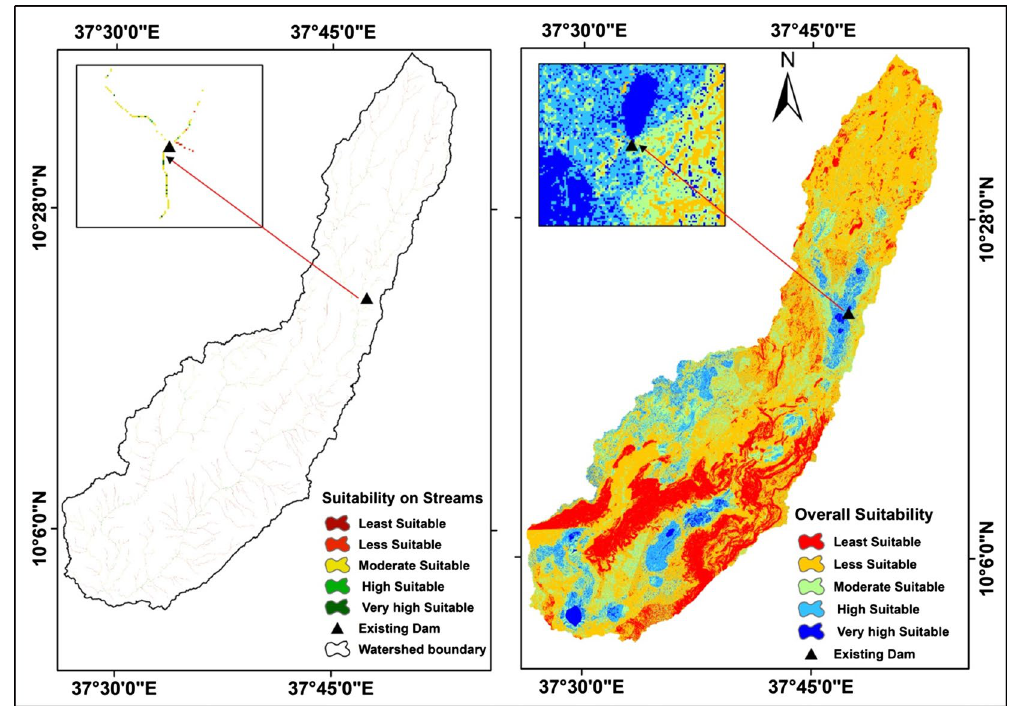
Fig. 24 Existing dam site location comparison with model output for